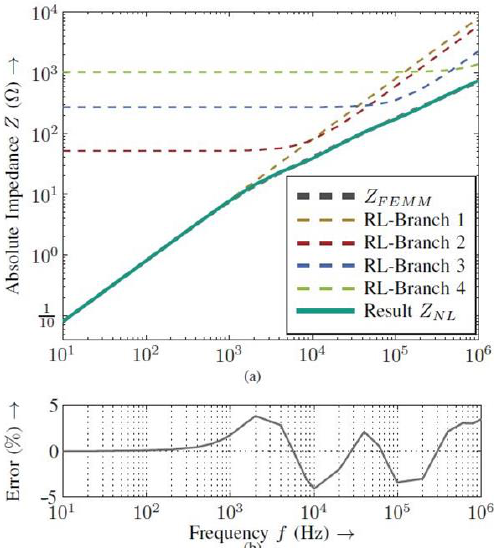
Figure 9. Impedance result of RL-branch compared to FEM in [58]. ( a ) Impedance ( b ) Error. Something similar is used in [22,26,28] for taking into account the resistance and inductance variation with frequency. They use Foster’s network, adjusting their values with data fitting procedures. The models are validated obtaining accurate results. Even if all models are based on LCR circuits, they refer to different parts of the machine and include different high-frequency